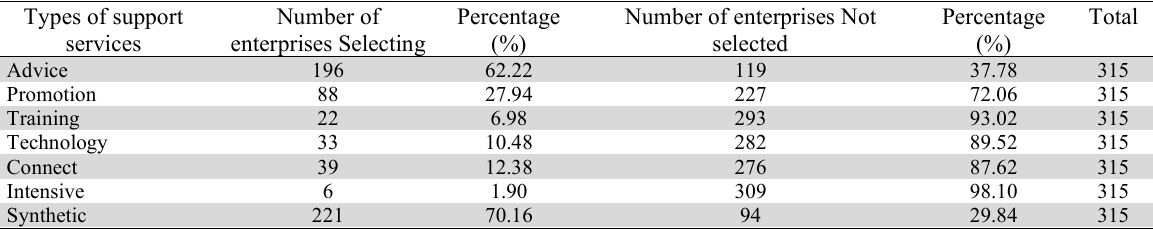
Rate of selection of information technology services of surveyed enterprises Types of